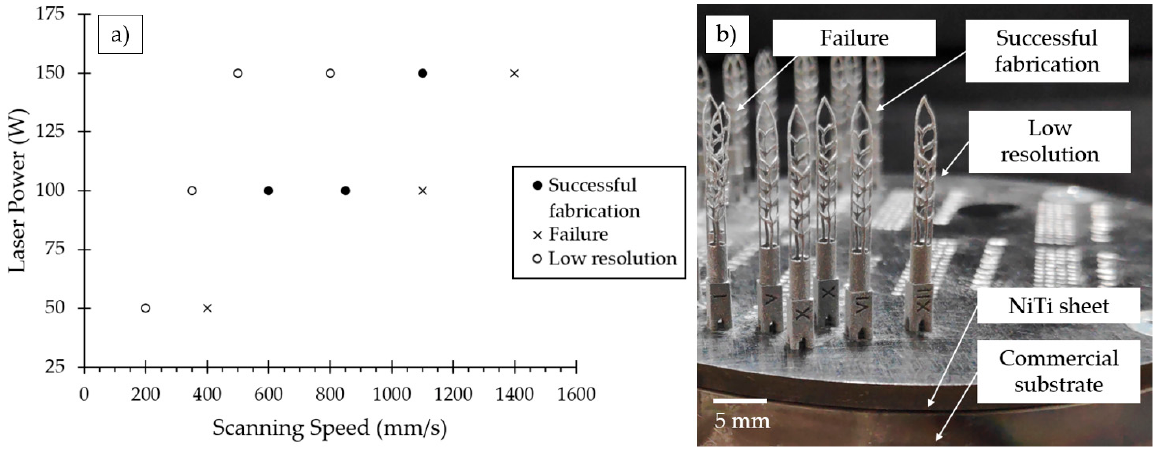
Figure 9. ( a ) Matrix of LPBF regimes of Self-Adjusting files fabrication; ( b ) Produced samples of